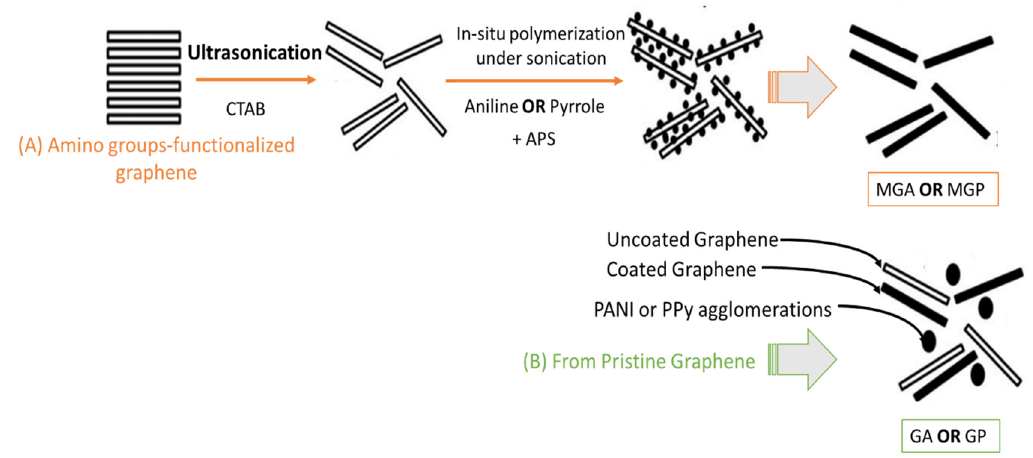
Figure 10. Preparation of PANI-based modified graphene (MGA) or PPy-based modified graphene (MGP) nanocomposites using ( A ) modified graphene and ( B ) pristine graphene yielding PANI/Graphene (GA) and PPy/Graphene (GP) (adapted from [6]). (Reprinted from Sahoo, S.; Bhattacharya, P.; Hatui, G.; Ghosh, D.; Das,